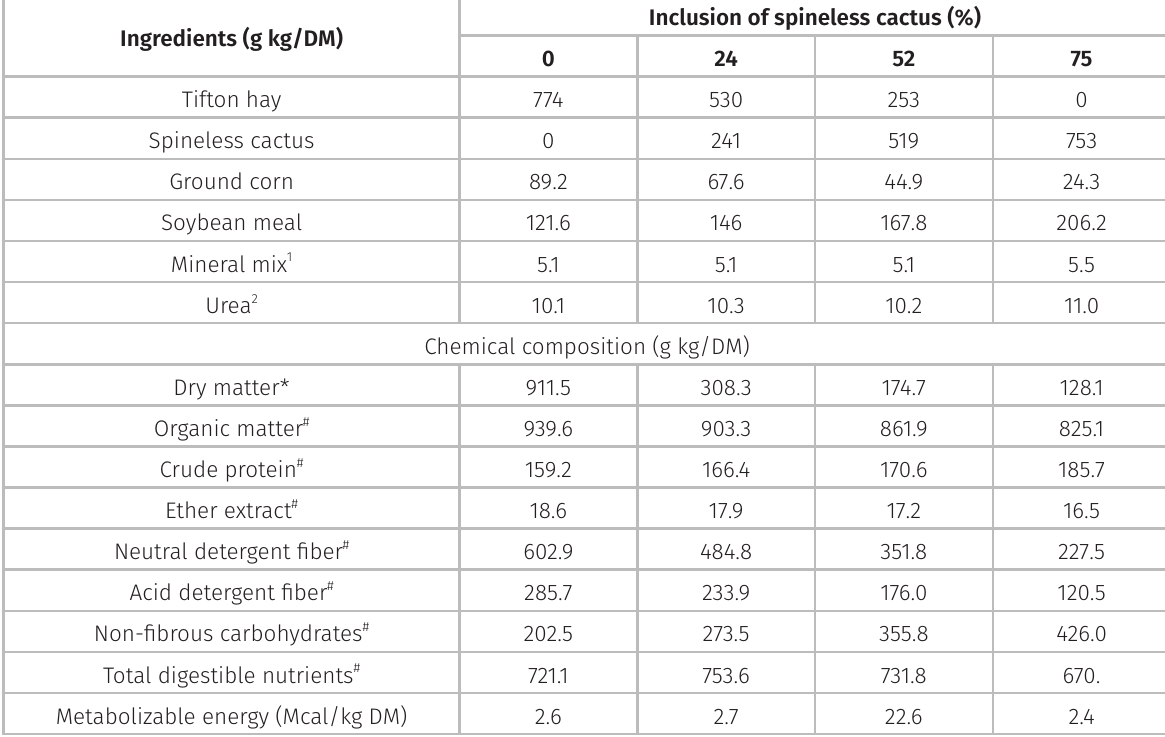
Table II. Proportion of ingredients and chemical composition of the experimental diets with increasing levels of spineless